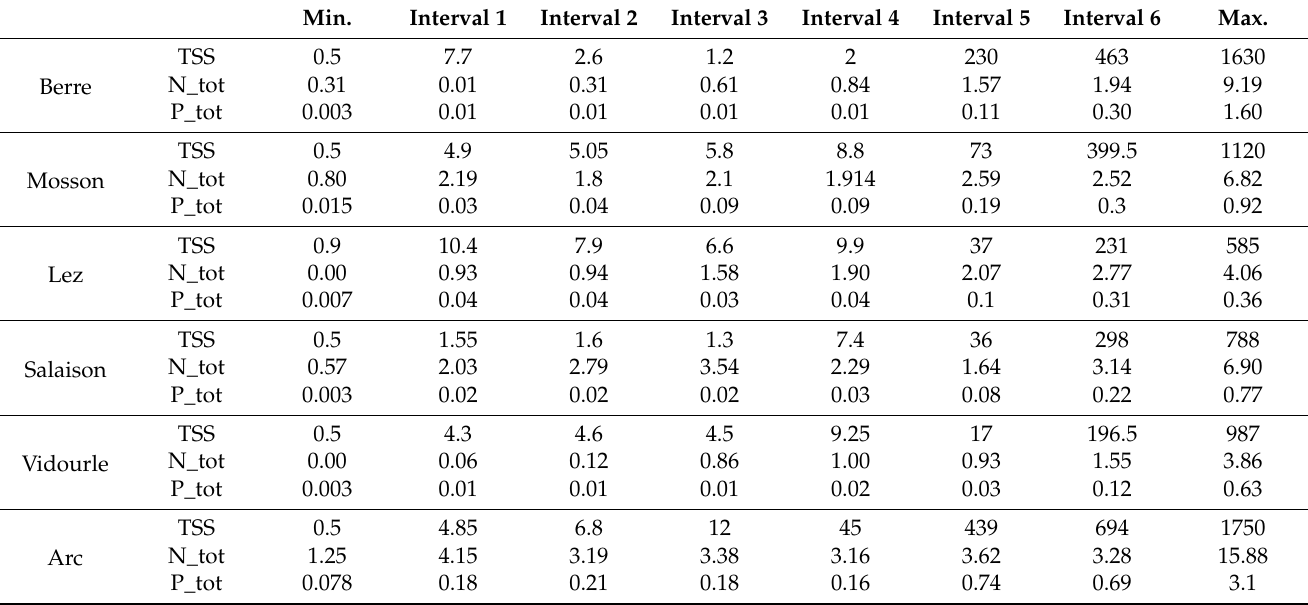
Table 5. Median concentrations (mg/L) of the six flow intervals using 2010–2020 data for the six rivers (TSS = total suspended solids; N_tot = total nitrogen; P_tot = total phosphorus; Min. = minimum value; Max. = maximum value).